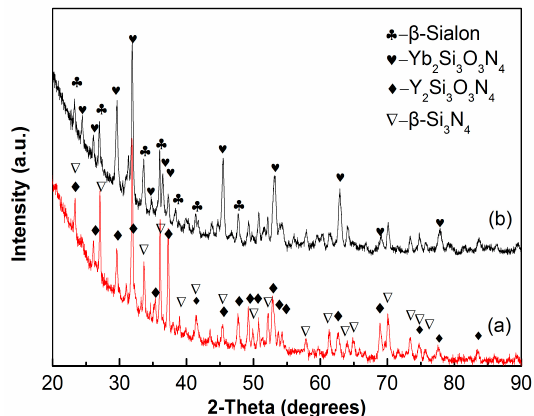
Figure 4. XRD (X-ray diffraction) patterns taken from the filler area of the ceramics joints bonded by ( a ) Y-SiAlON and ( b ) Yb-SiAlON, respectively.